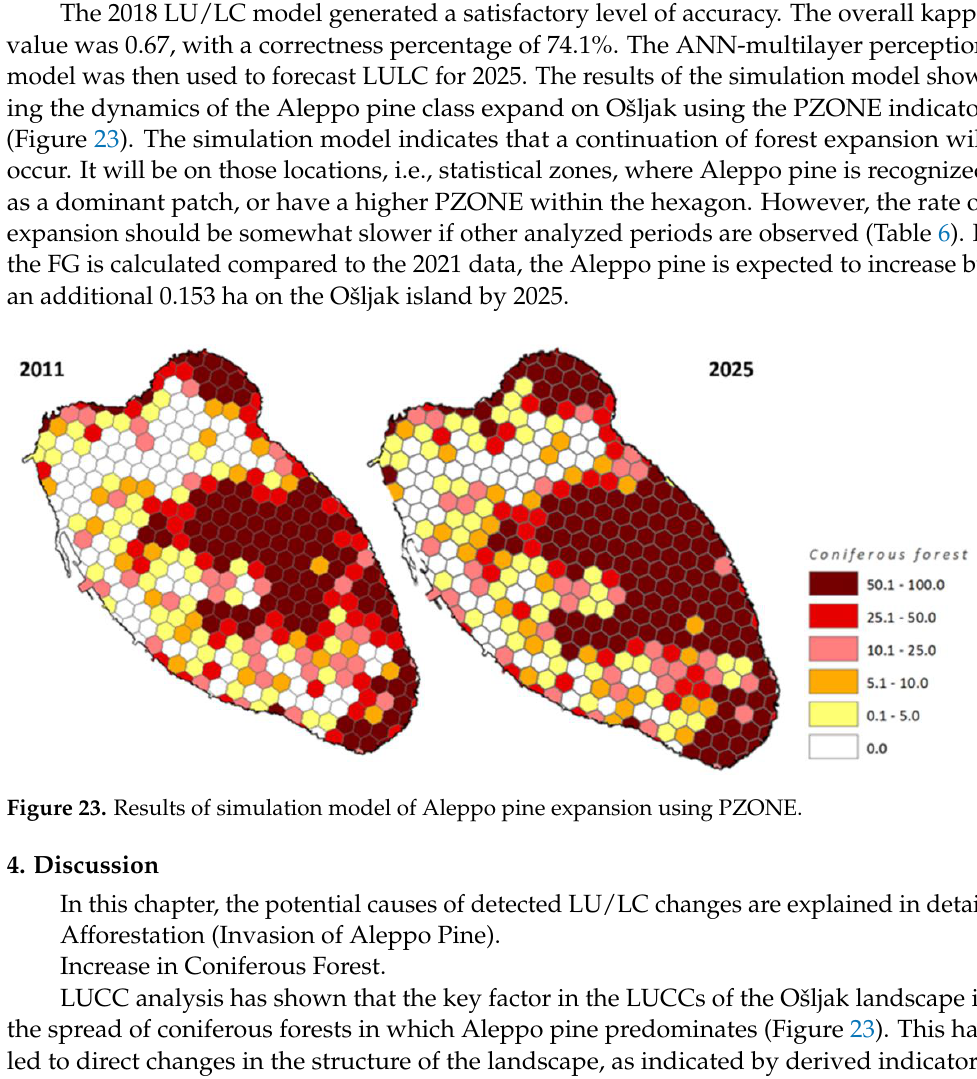
Figure 22. Fragmentation of cadastral parcels for the 1776–2021 period.